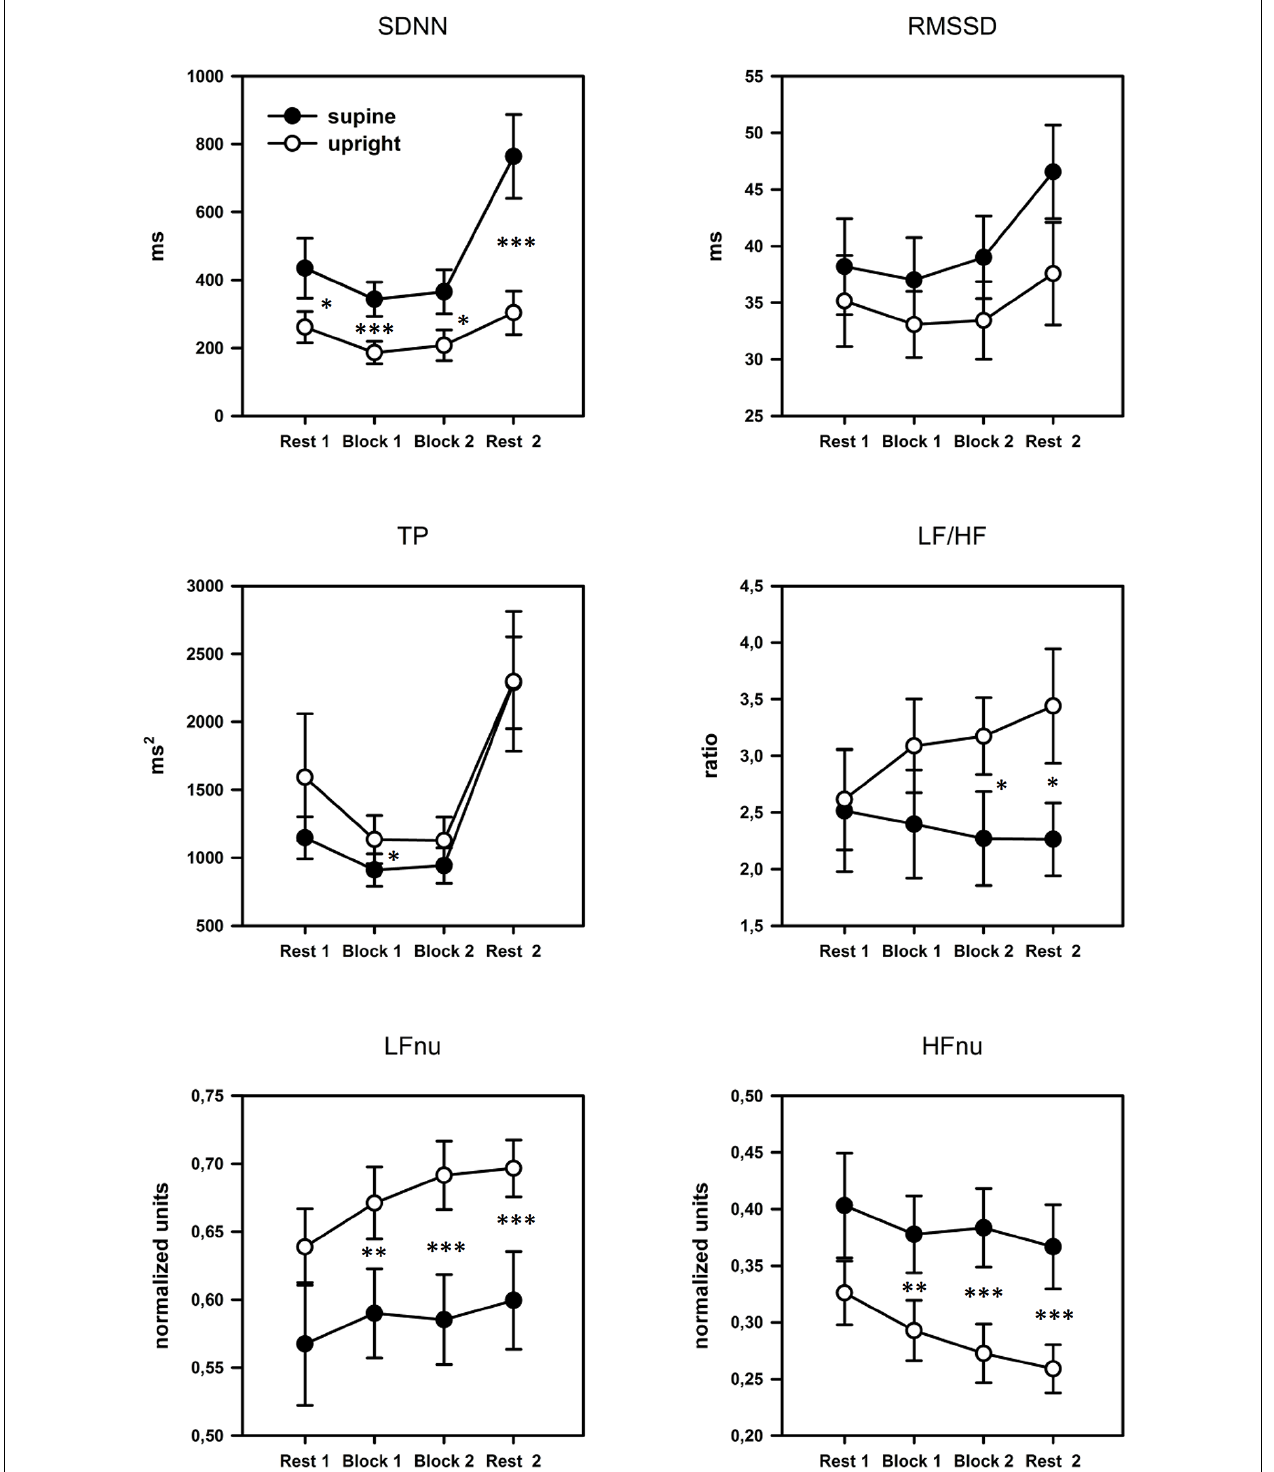
FIGURE 4 | Profile plots of the time and frequency domain HRV parameters over the four blocks. Error bars indicate SEM. SDNN, SD of all NN intervals; RMSSD, square root of the mean squared difference between adjacent NN intervals; TP, total power; LF,